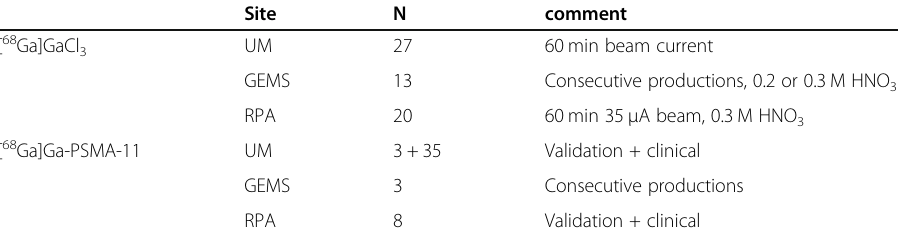
Table 4 High-level summary of 68 Ga runs reported herein for UM, GEMS and